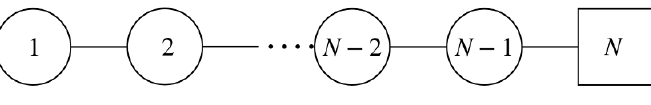
Figure 2 . T [SU( N )]